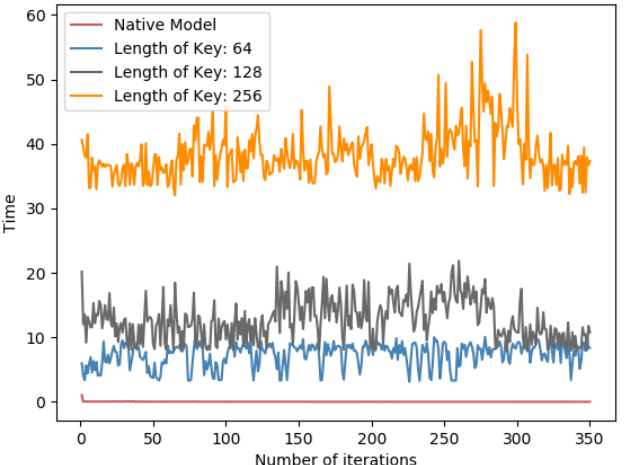
Figure 9. Per-iterations time spent for different key lengths on the fatigue